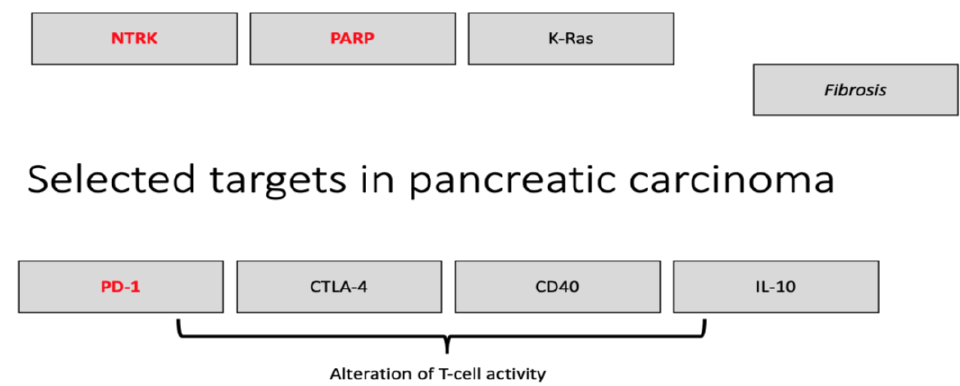
Figure 1. Overview of selected therapeutic targets in locally advanced/metastatic pancreatic carci- noma. Red indicates that therapies have already been approved for this tumor entity.